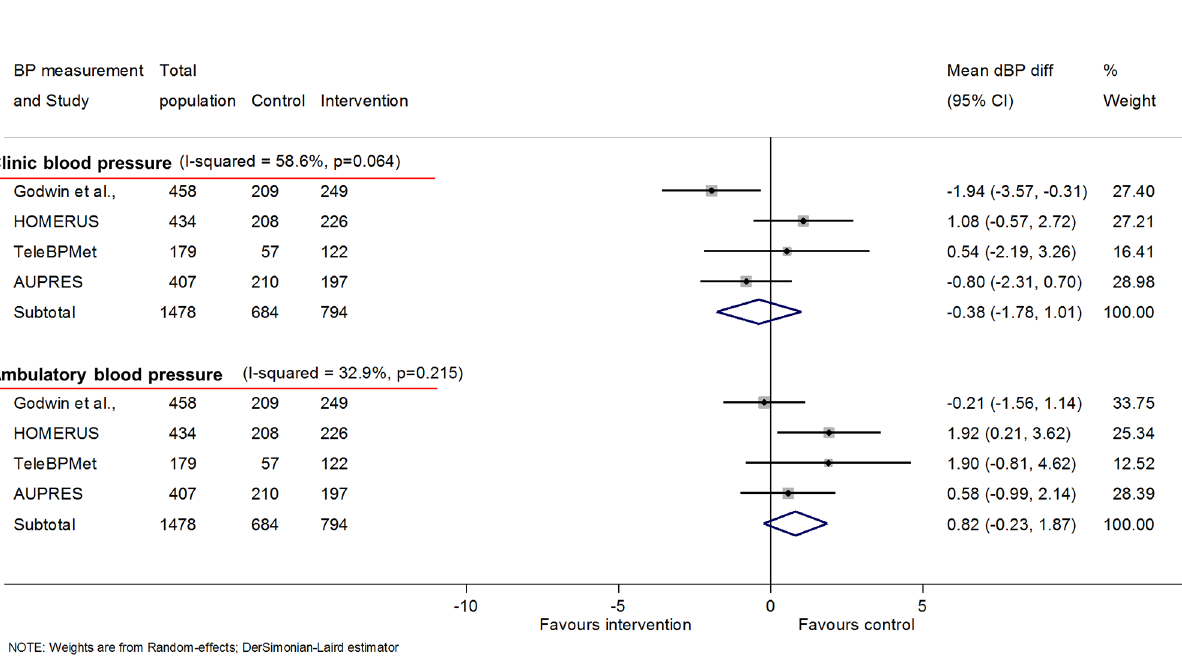
PLOS Medicine| https://doi.org/10.1371/journal.pmed.1002389 September 19,